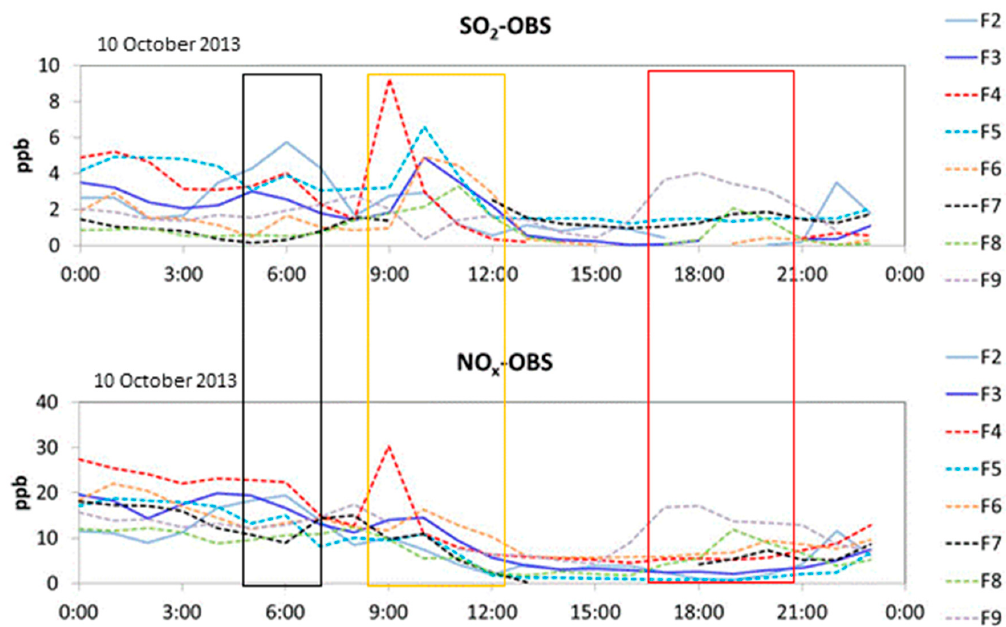
Figure 6. Diurnal variations of SO 2 and NO x observations (OBS) at eight AQSs on 10 October 2013.